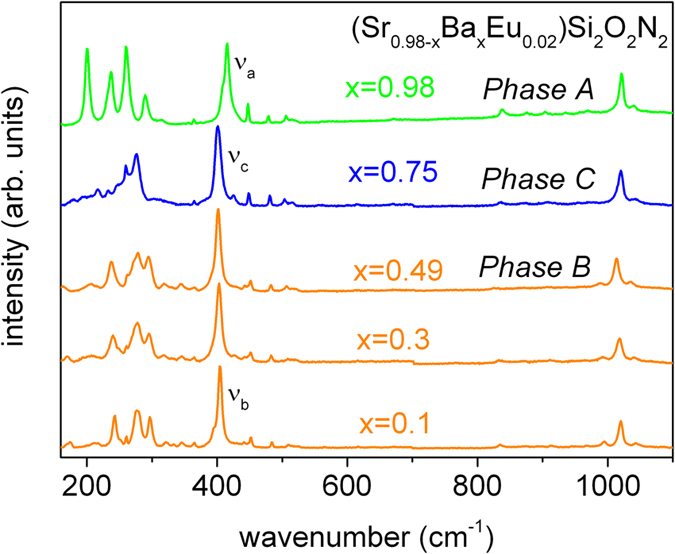
Raman spectra of (Sr0.98-xBaxEu0.02)Si2O2N2 for different Ba content x.